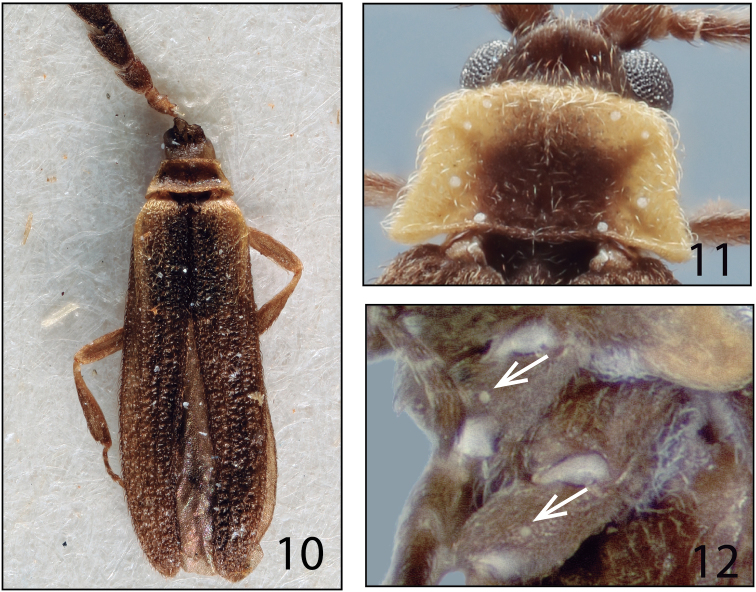
10) Dorsal habitus of Lycinellahumeralis. 11 Pronotum and pronotal stemmata of L.parvula12 Stemmata in pro- and mesocoxae of L.pugliesae.